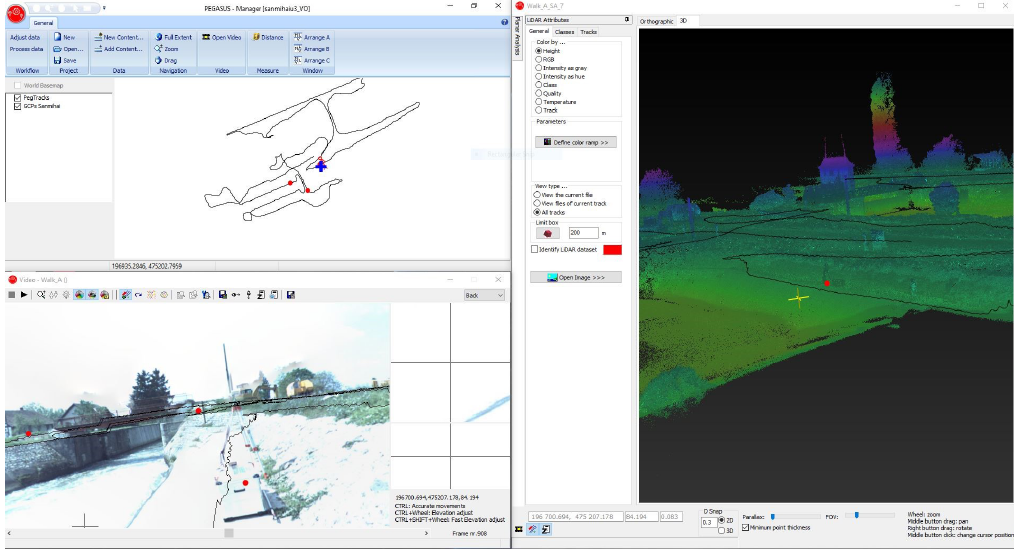
Figure 22. LiDAR point clouds and their height coloring.